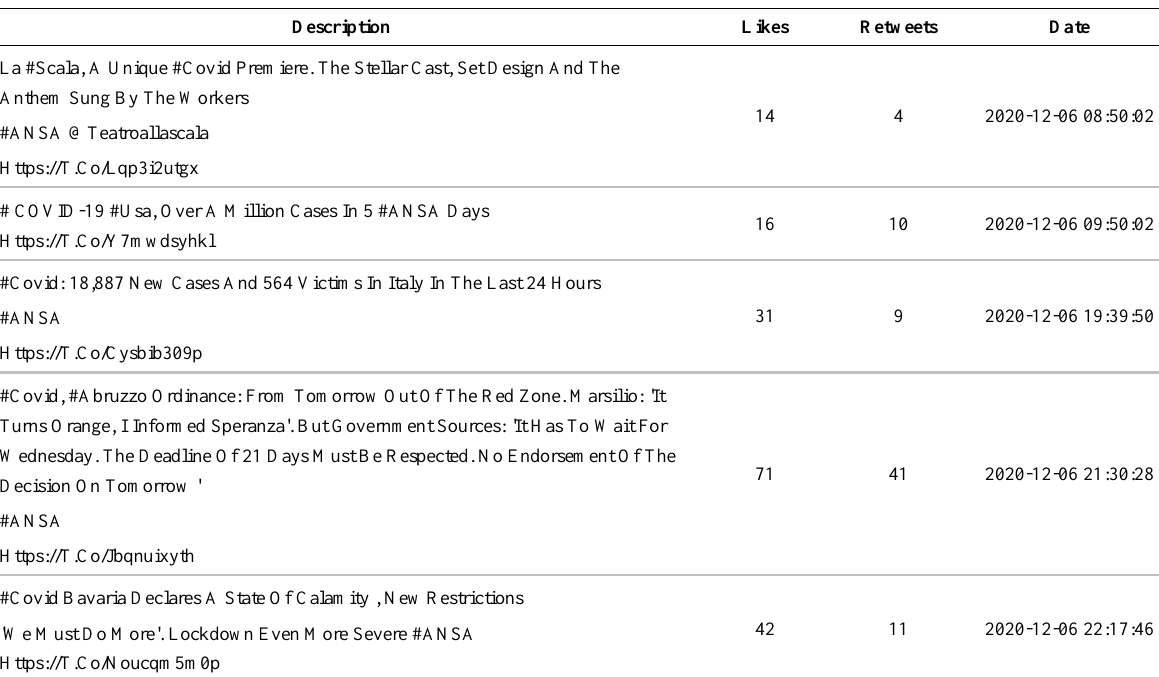
Table 2. Extracted